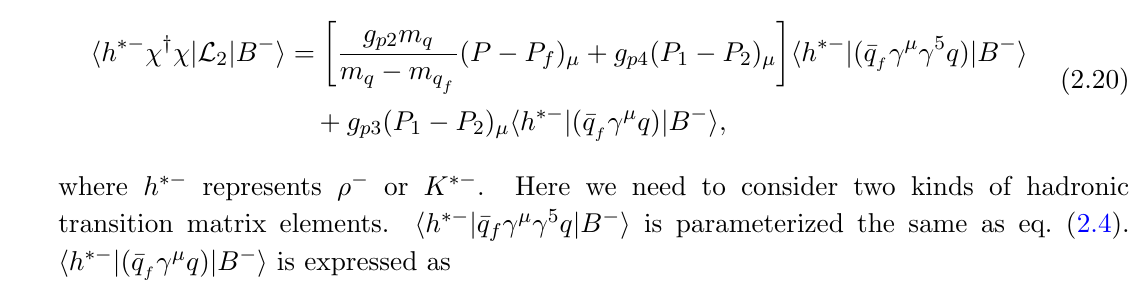
2 and 2 deduced from B (cid:0) g p 1 g p 3 j j j j